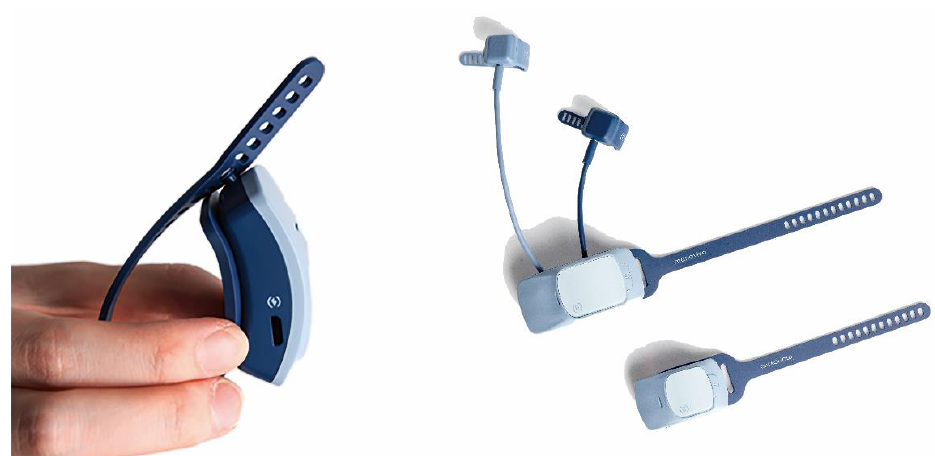
Figure 3. Design features: customization, flexibility, and extensibility .